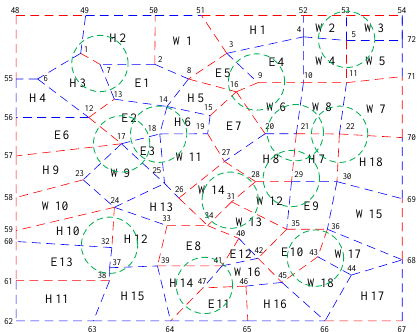
Figure 3. Road network model and EVCS location.